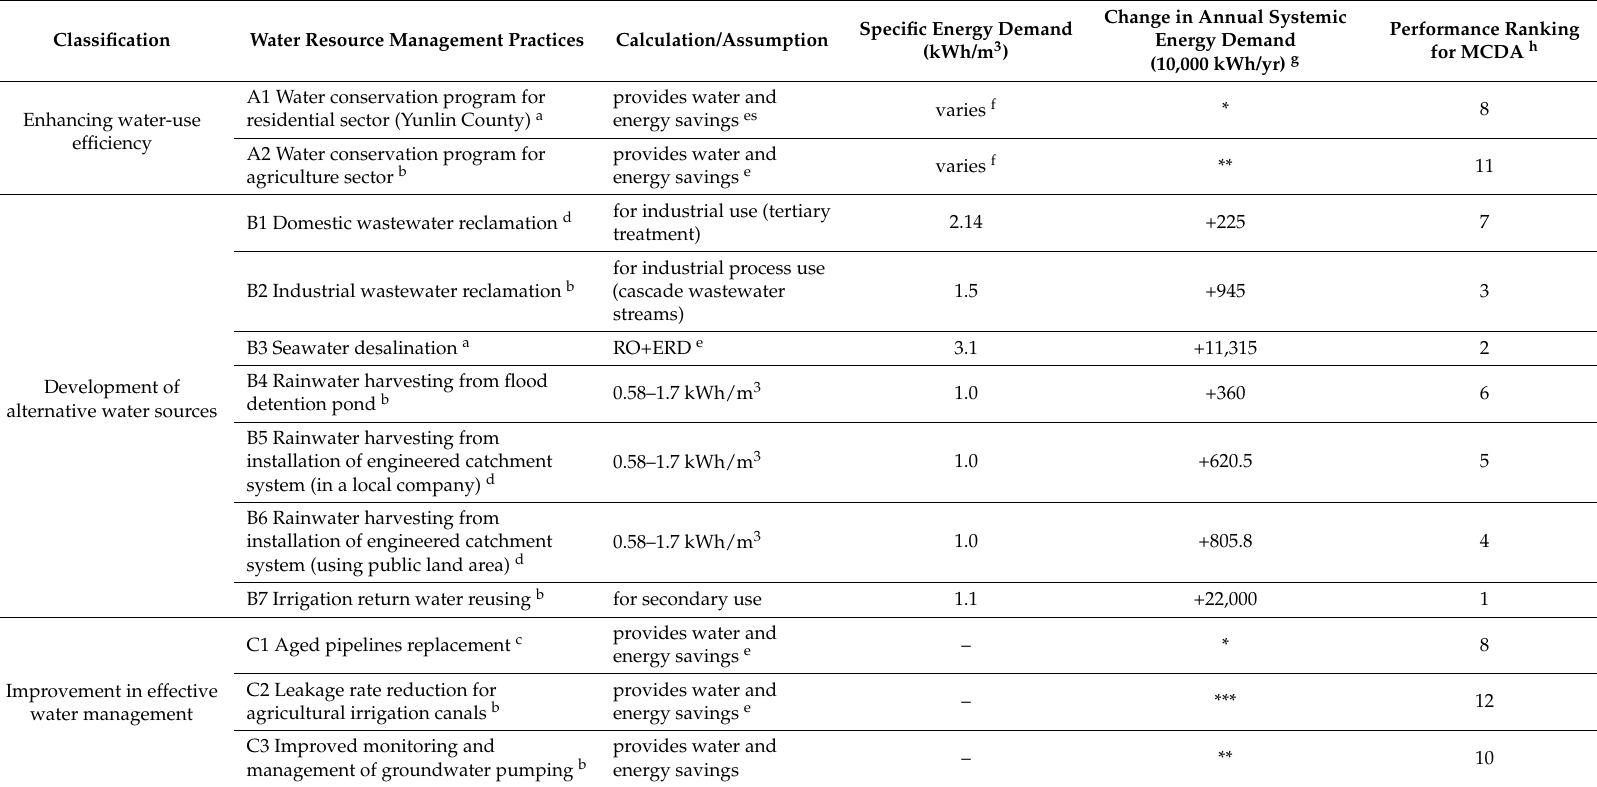
Table 6. Performance of systemic energy efficiency and assigned rating value for the proposed